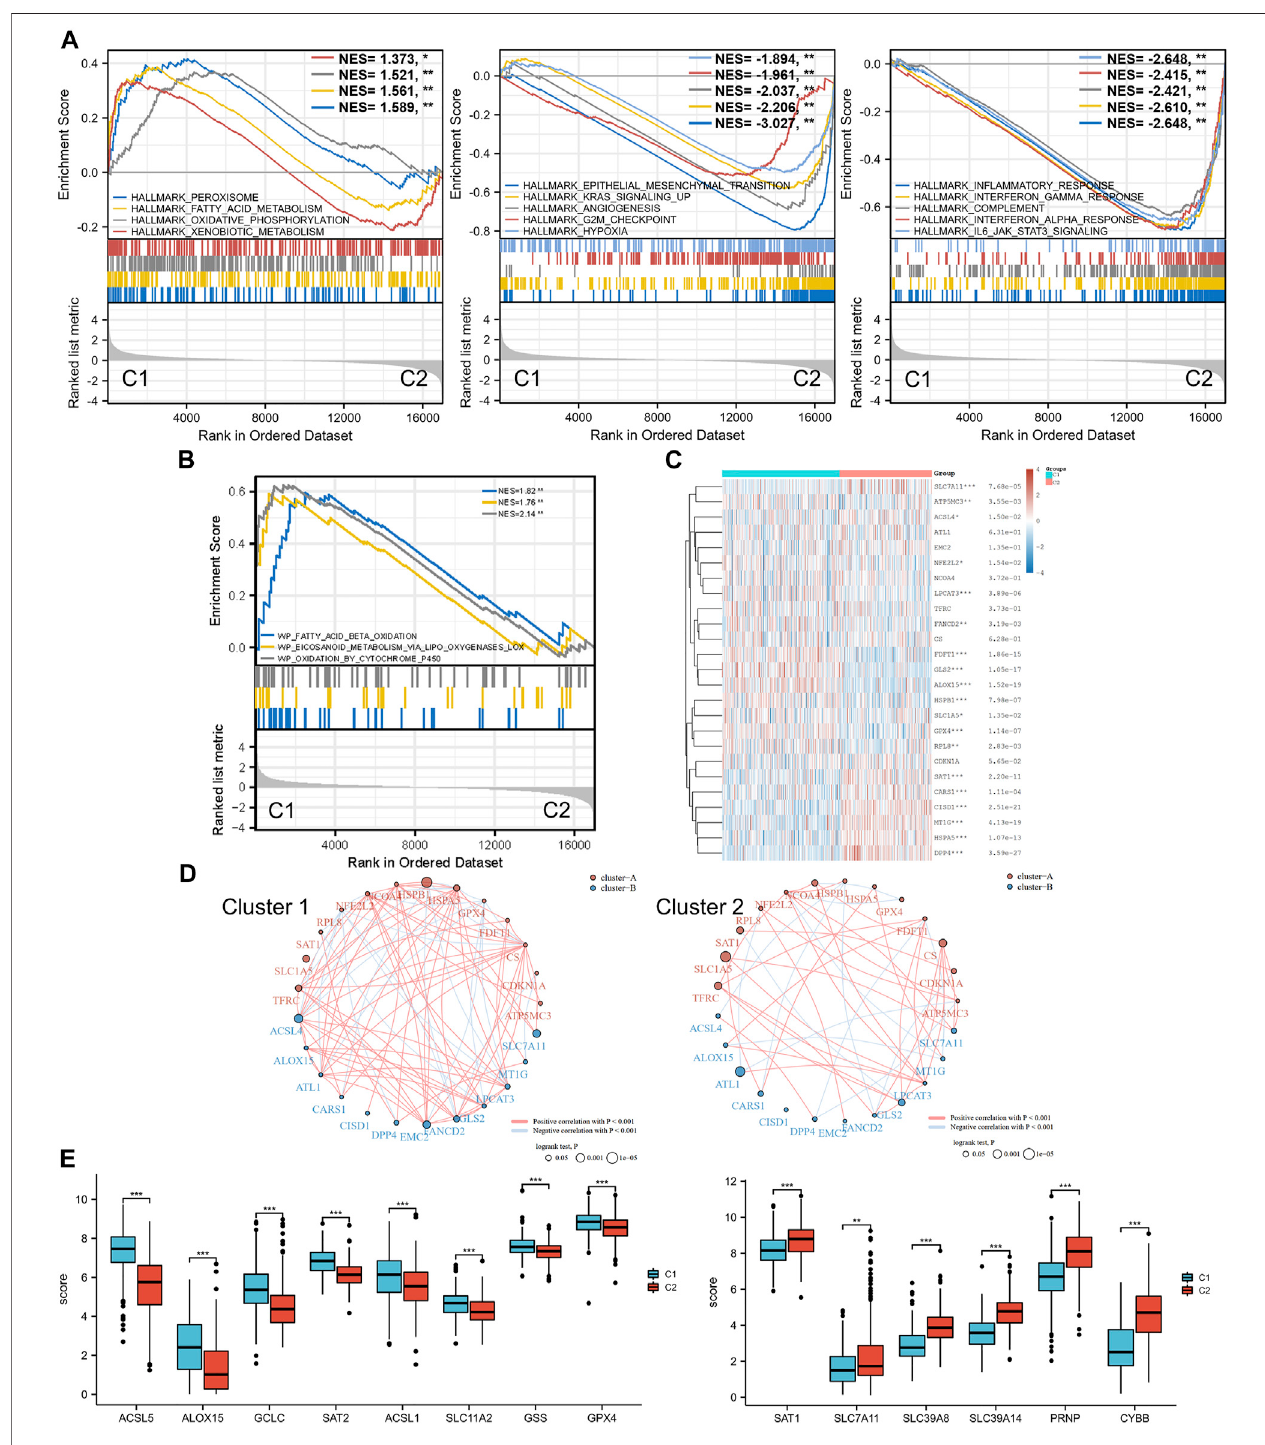
FIGURE 3 | Ferroptosis status analysis and GSEA results. (A) GSEA of DEGs that were upregulated in cluster 1 and cluster 2. (B) GSEA results of lipid oxidation metabolism terms. (C) Heatmap of ferroptosis-related gene expression in two different metabolic status clusters. (D) Ferroptosis-related gene interaction network. The red and blue lines represent the positive and negative correlation, respectively. The thickness of the line represents the correlation between the two genes. The larger circle indicates a more signi fi cant prognostic log rank p value. (E) Expression difference of ferroptosis-related genes between the two clusters. GSEA: gene set enrichment analysis. DEG: differentially expressed genes. * p < 0.05, ** p < 0.01, *** p < 0.001.